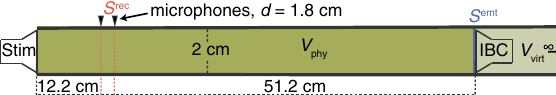
FIG. 5. Waveguide used for the demonstration of nonreflecting IBCs, where the virtual medium corresponds to a homogeneous half-space.